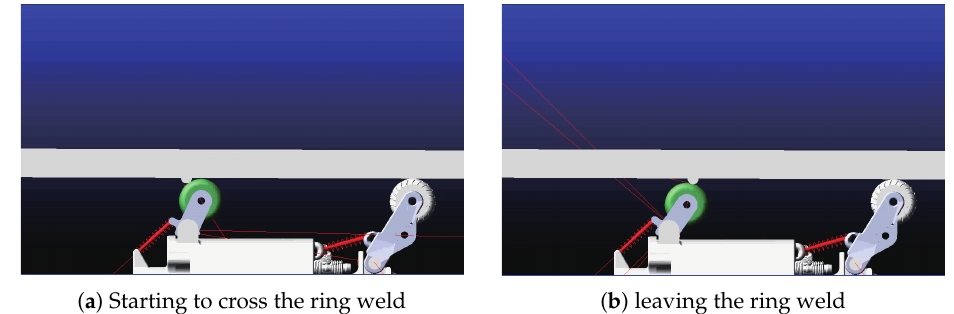
Figure 9. The robot is crossing the ring weld barriers.